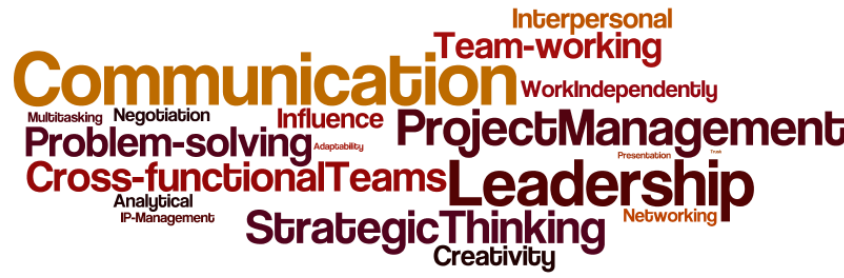
Fig. 4. Word buzz of common skills for open innovation professionals based on job advertisement